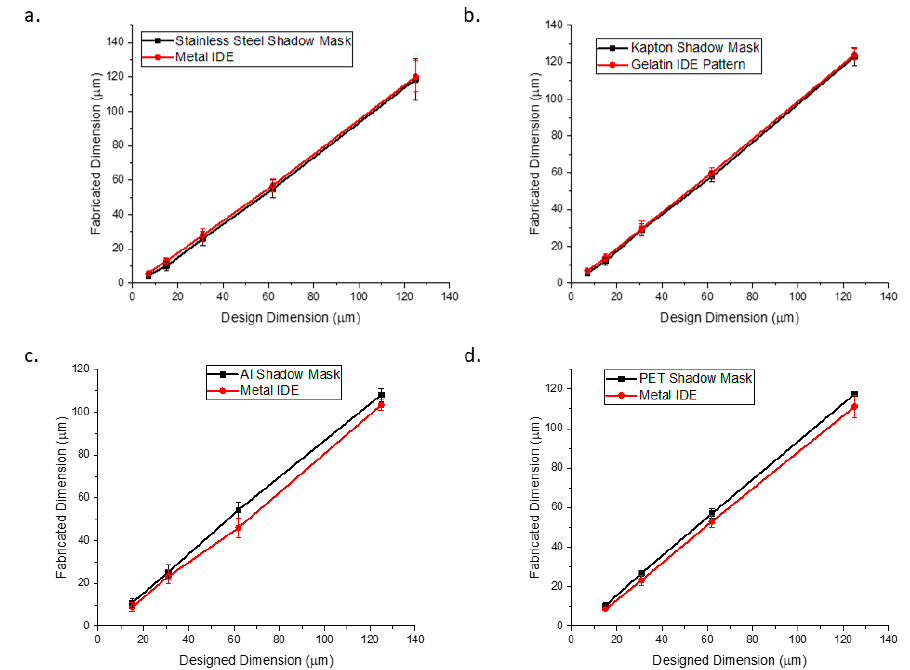
Figure 11. Design to shadow mask to device (interdigitated electrode (IDE) on glass) for the four materials that cut all the way through the substrate: ( a ) stainless steel to Ti-Au metal IDE; ( b ) Kapton ® to gelatin IDE pattern; ( c ) aluminum to Ti-Au metal IDE, and ( d ) PET to Ti-Au metal IDE.